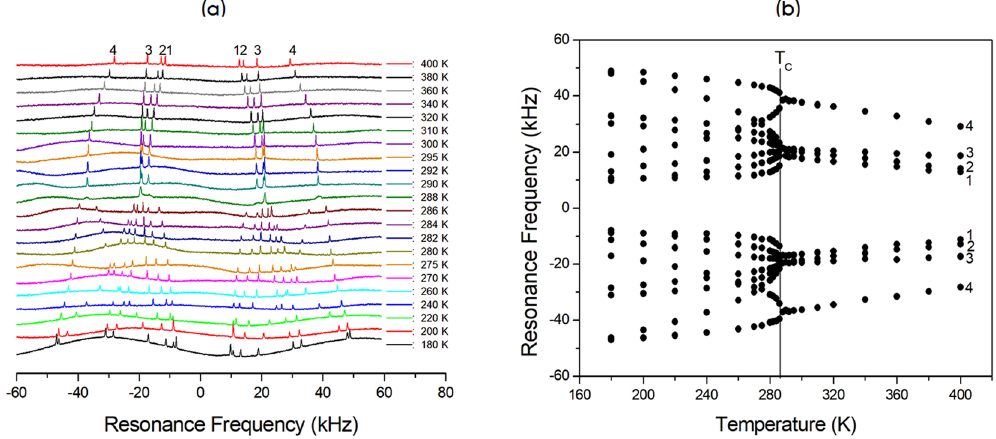
Figure 8. ( a ) In-situ 14 N NMR spectrum as a function of temperature for [N(CH 3 ) 4 ] 2 Zn 1- x Cu x Br 4 ( x = 0). ( b ) Resonance frequency of the 14 N NMR spectrum as a function of temperature for [N(CH 3 ) 4 ] 2 Zn 1- x Cu x Br 4 ( x =